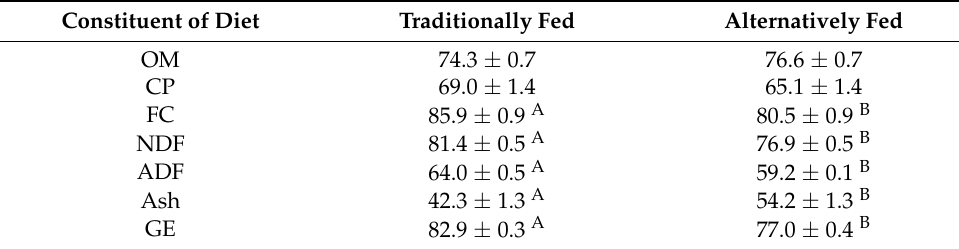
Table 5. Digestibility of buffalo diets characterized by different NSC/CP ratios in traditionally fed and alternatively fed